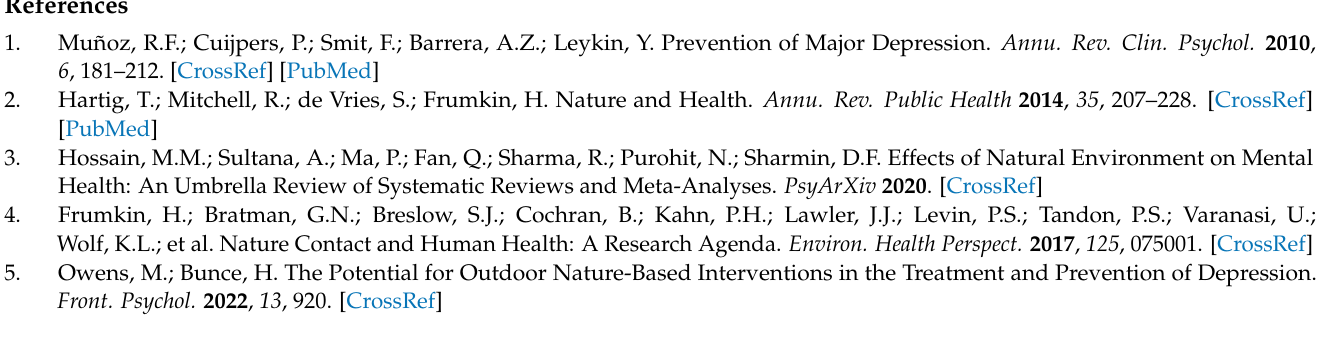
Database; Table S1: Summary of the Measurement Tools Used in Each Study; Table S2: Summary of Papers by Outcomes; Table S3: Component Ratings for EPHPP Quality Appraisal